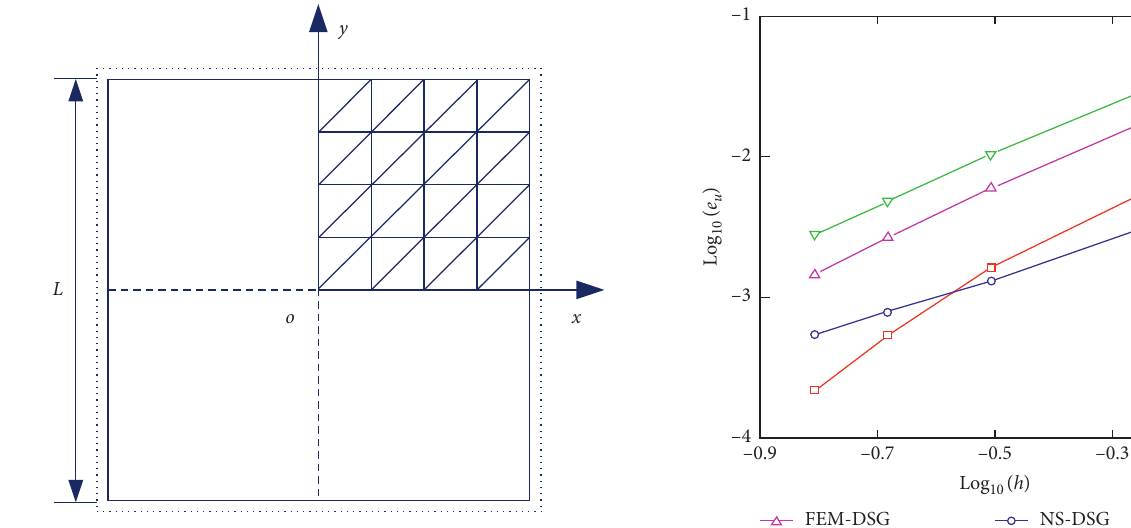
Figure 3: A square plate with a simply supported boundary condition. Table 1: Numerical results of normalized central deflection 􏽢 w for the simply supported square plate subjected to uniform load.